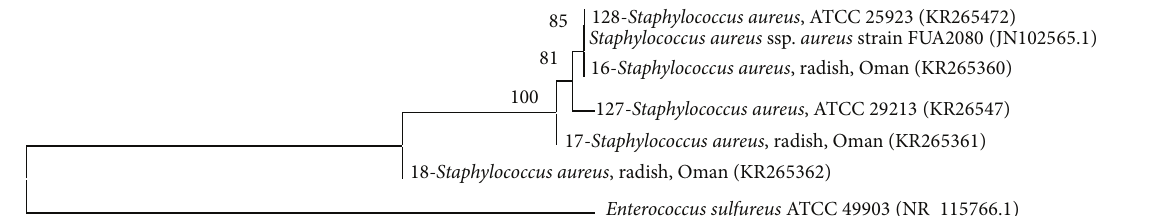
Figure 4: Neighbor joining tree based on 16S rRNA gene sequences of Staphylococcus aureus isolated from local radish. Enterococcus sulfureus ATCC 49903 (NR115766) was included as an outgroup. KR-accession numbers correspond to gene sequences that belong to isolates analyzed in this study while others were obtained from NCBI database. Bootstrap values above 50% are shown (1000